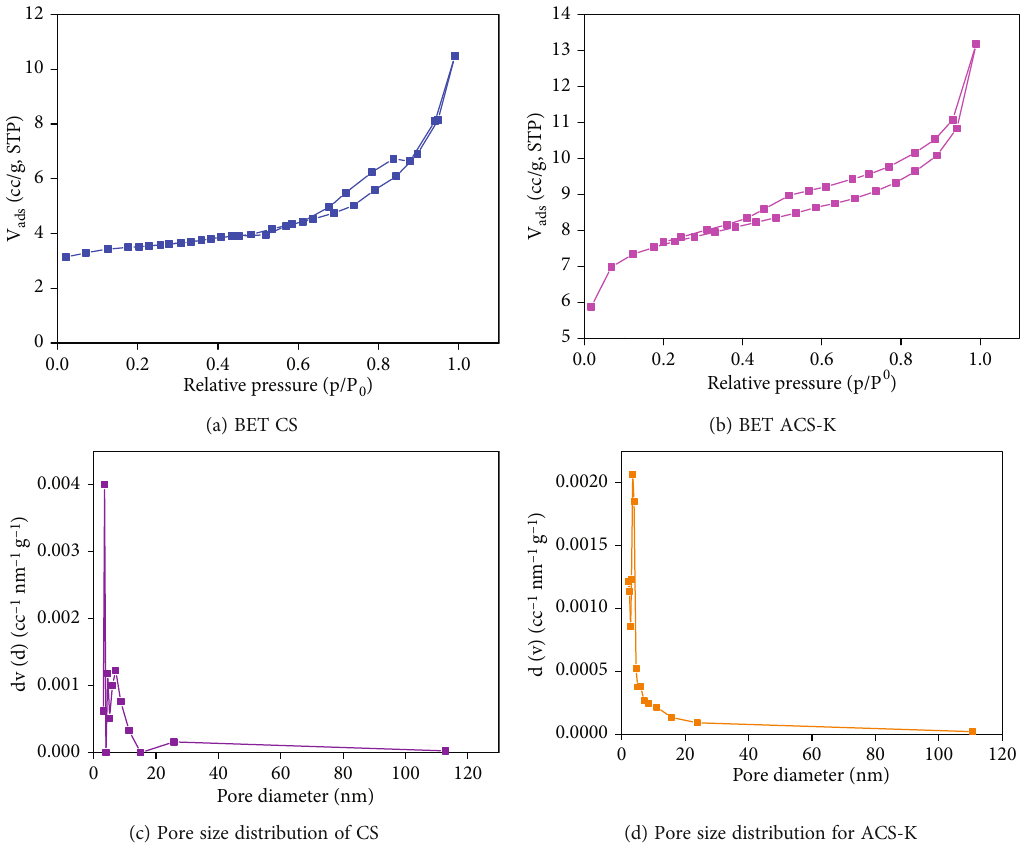
Figure 3: BET analysis of CS and ACS. (a) and (b) show nature of pores on CS. (c) and (d) for